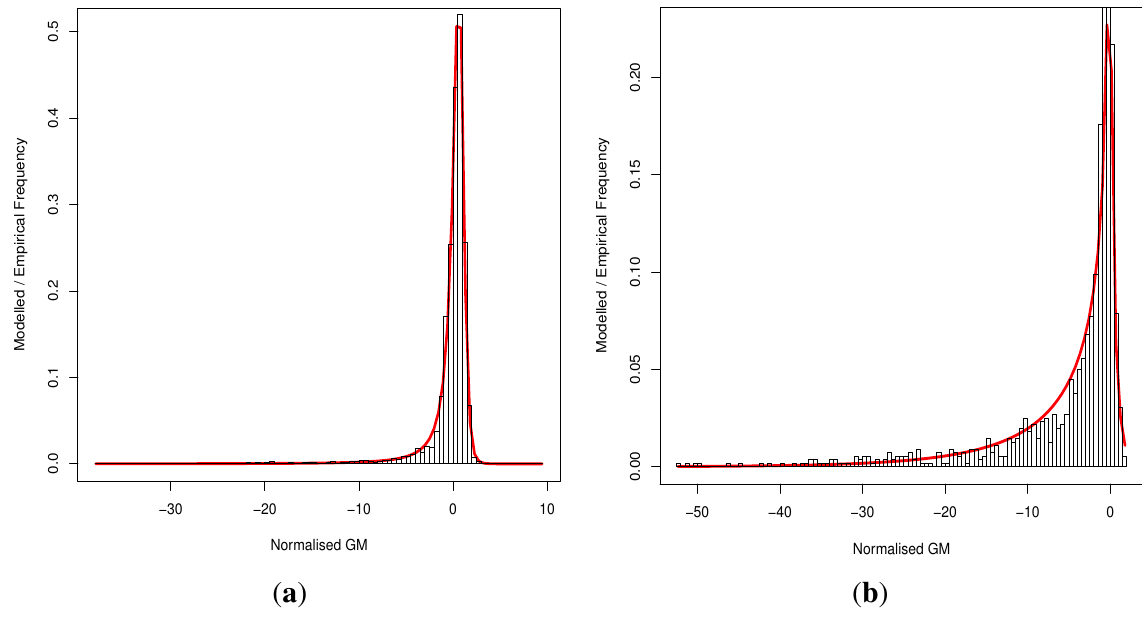
Figure S2. Empirical and modelled variant distributions based on lowest-AIC distribution for set as detailed in Table S1. ( a ) Deleterious; ( b ) Neutral.